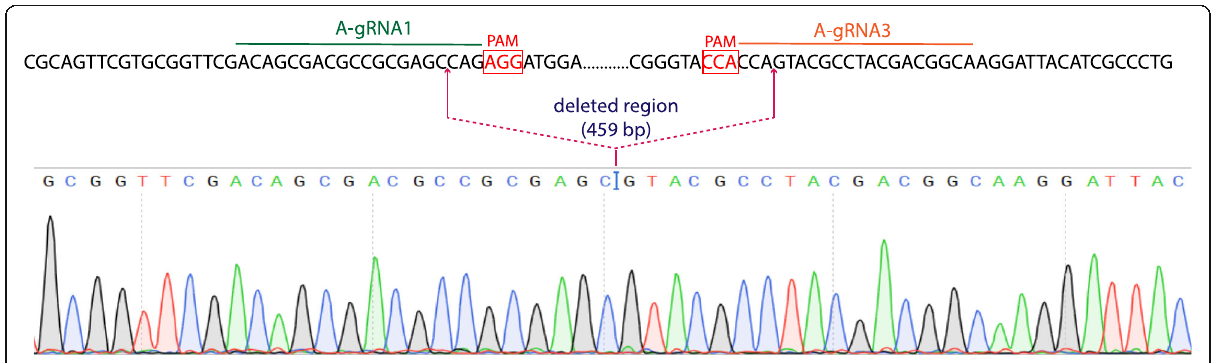
Fig. 5 Exact position of deleted sequence. Sanger sequencing results reveal 459 bp deleted region from the entire HLA-A